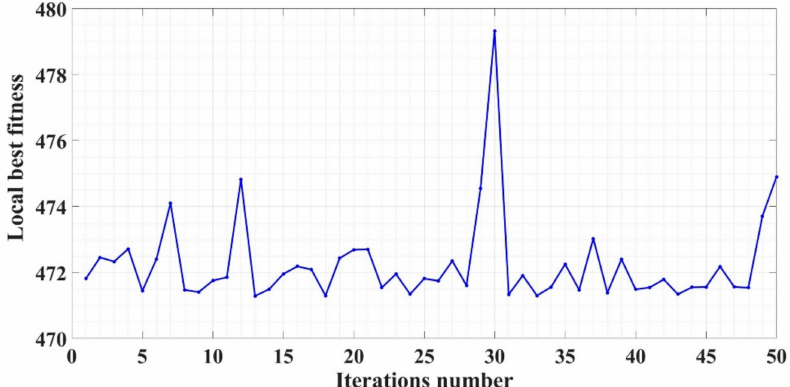
Figure 11. Evolution of the performance of the PSO-type